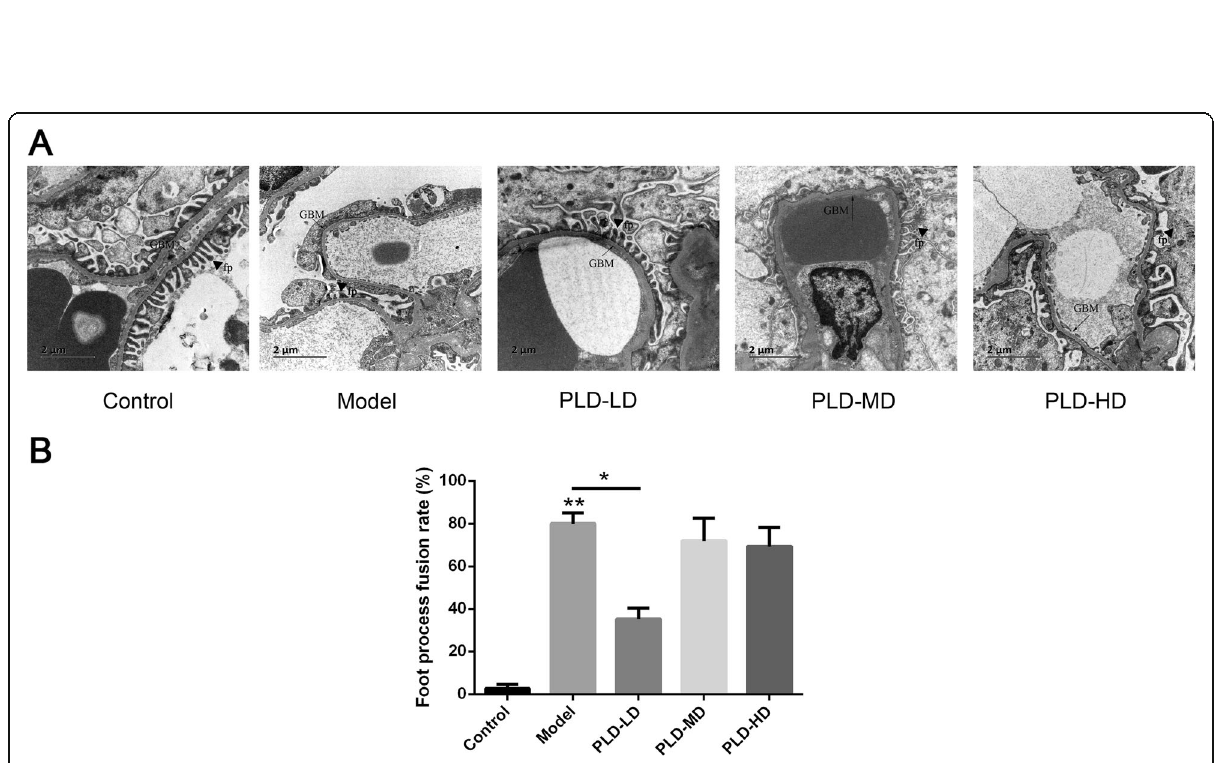
Fig. 3 Analysis of renal pathology by light microscopy. a Representative micrographs from each group are shown. The upper panel represents H & E staining and the lower panel represents the Masson ’ s staining (original magnification × 200). b The GSI of each group. Data are presented as the mean ± SD. * p < 0.05; ** p < 0.01